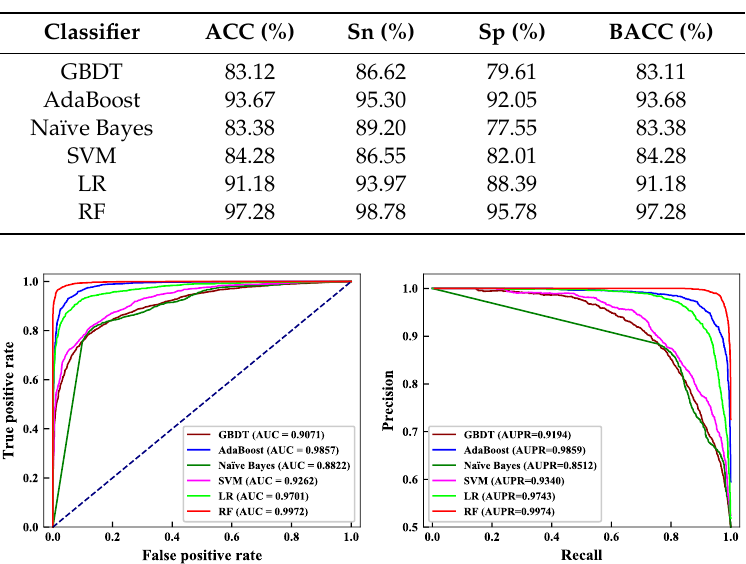
Table 9. Comparison of prediction results of six classifiers.